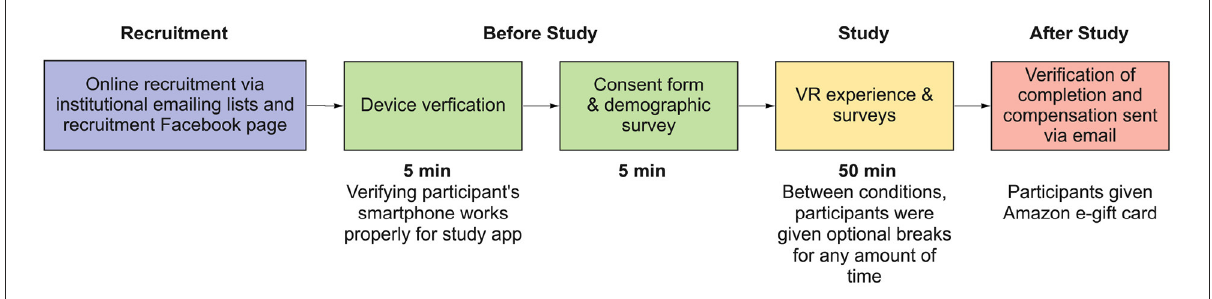
FIGURE11 Visualization of the study procedure of the field of view and target search